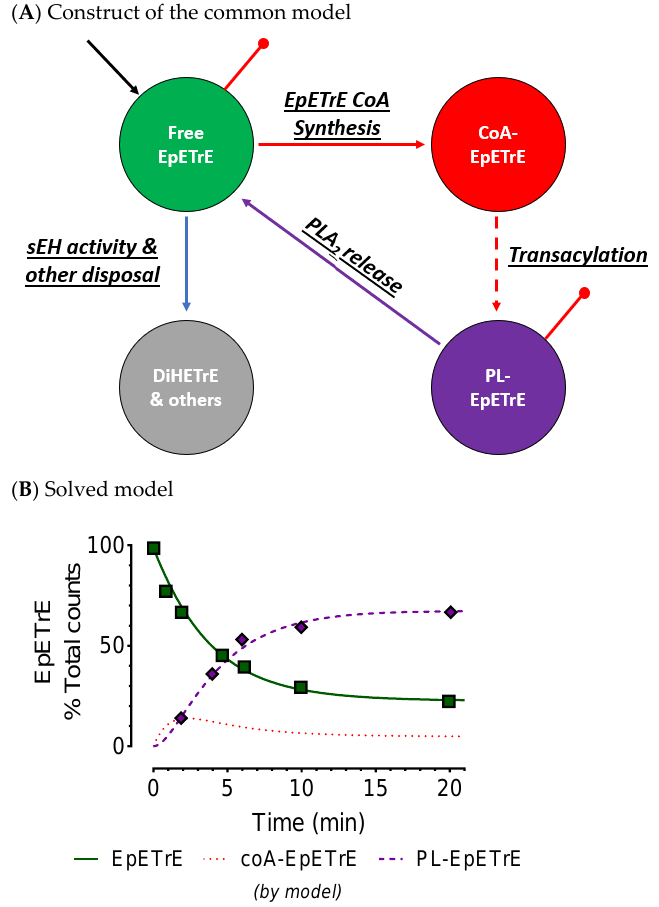
Figure 2. Extant data confirm active role for esterification. An expression of the common model is shown demonstrating the role of intracellular esterification of EpETrE ( A ); components modeled here are shown color coded for ( A , B ). Input into the green compartment (black arrow) represents novel EpETrE synthesis. Esterification into PLs is a two-step process: thioloization into coA-EpETrE (red compartment), and acyltransferase activity with lyosophospholipids to create a phospholipid- compartment) and is represented by the blue arrow. Red dots represent directly observed